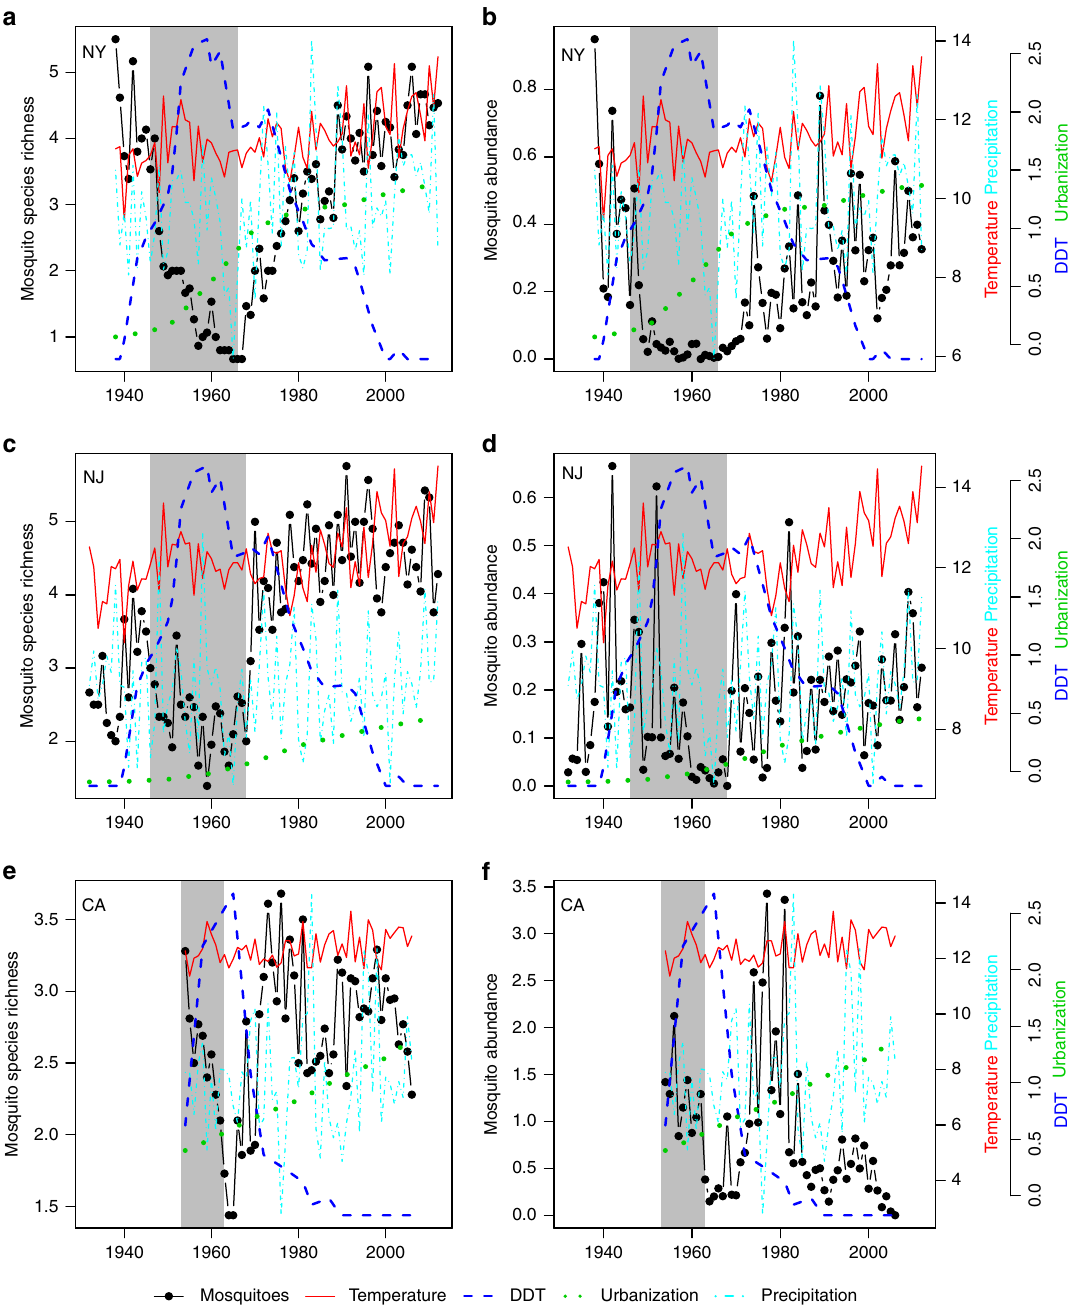
Figure 1 | Time series of species richness and abundance of mosquitoes. Left panels and left axis show mosquito species richness, expressed as the average number of species collected per trap per night from New York (NY) ( a ), New Jersey (NJ) ( c ), and California (CA) ( e ). Right panels show mosquito relative abundance per trap night expressed as Z -scores from New York (NY) ( b ), New Jersey (NJ) ( d ) and California (CA) ( f ). For all panels, the first right axis shows temperature and precipitation. Temperature (solid red line) is the yearly average in degrees Celsius calculated from November of the preceding year through the following October. Precipitation (dashed light blue line) is the yearly average in centimeters. The second right-hand y axis shows DDTusage and urbanization, again for all panels. Relative DDTconcentration (dashed dark blue line) is expressed as a Z -score and the period of DDT use by the mosquito control districts is indicated by the grey rectangle. Urbanization (dotted green line) is expressed as the human population in millions in NY and NJ and in 100,000s in